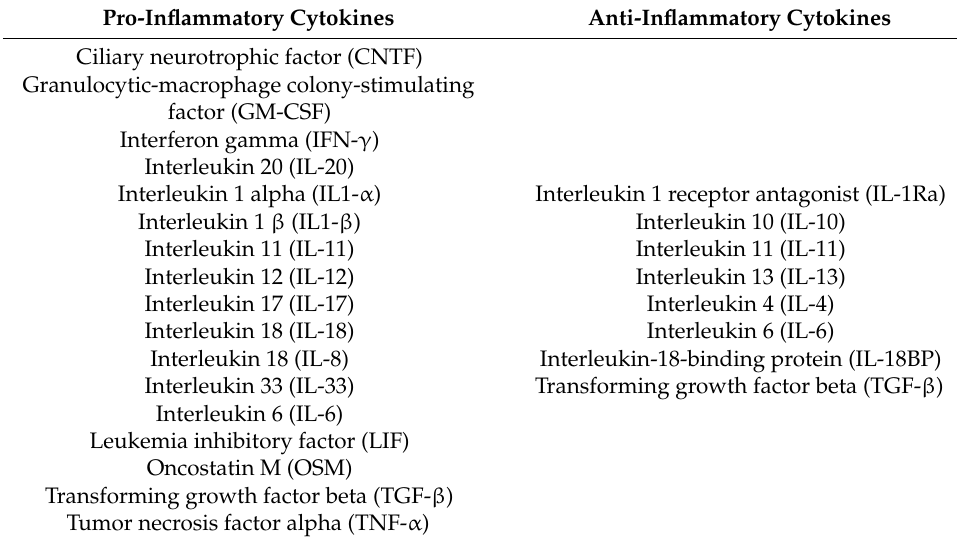
Table 3. Pro-inflammatory and anti-inflammatory cytokines. Pro-Inflammatory Cytokines Anti-Inflammatory Cytokines Ciliary neurotrophic factor (CNTF) Granulocytic-macrophage